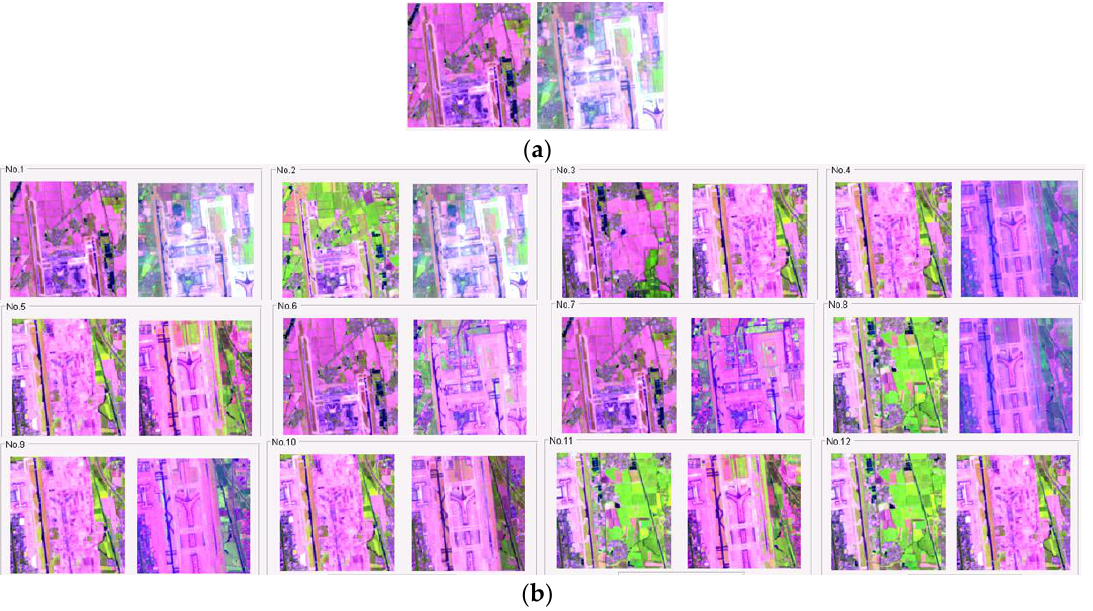
Figure 9. Query by example: looking for “BAR2BUI” (bare land to Beijing airport) in a database of remote sensing images. ( a ) The target pair of query images. ( b ) Pairs of images retrieved using the proposed method based on Color Moments. The 12 most similar pairs of images are shown.